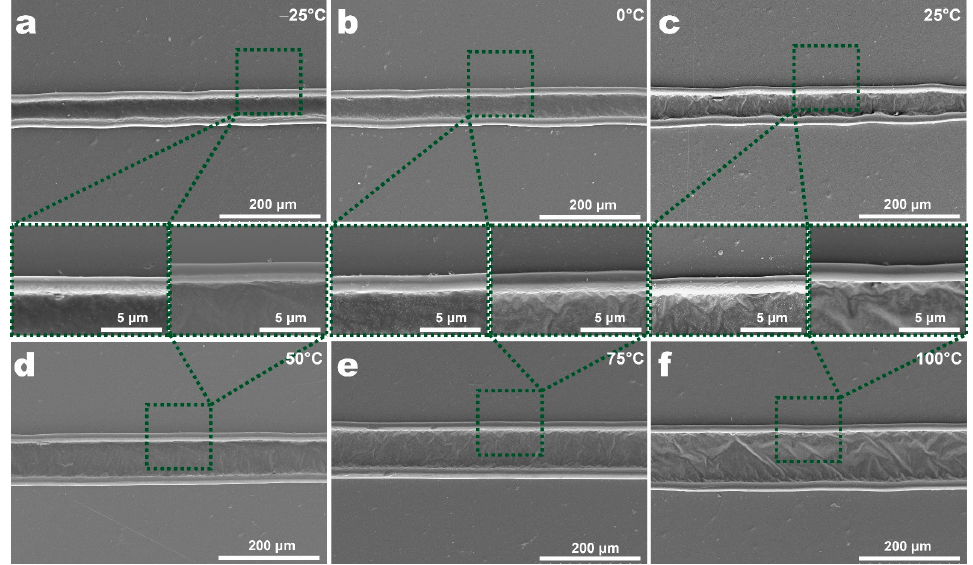
Figure 10. SEM images of kerfs of PET films at different ambient temperatures in line laser pro-